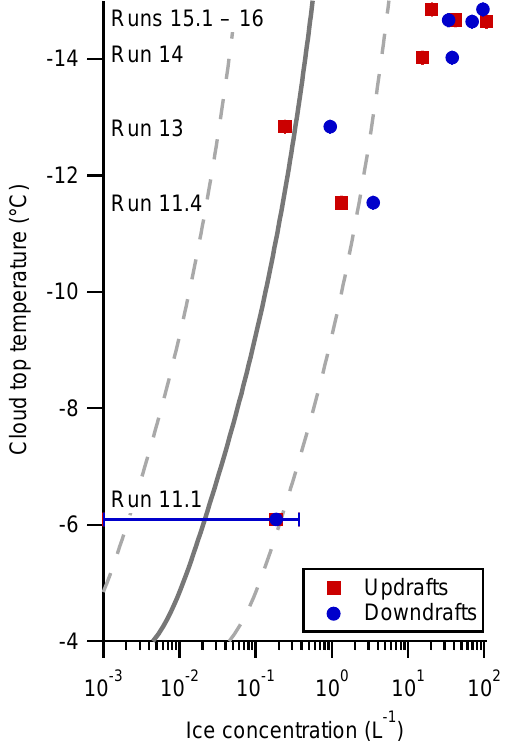
Figure 13. Mean ice concentrations measured during the runs in Figs. 7–11. The displayed errors are Poisson counting errors, which were negligible for all runs other than run 11.1. The solid grey line is the IN concentration calculated using the DeMott et al. (2010) parametrisation, and the dashed grey lines are 10 × and 0 . 1 × the DeMott et al. (2010)